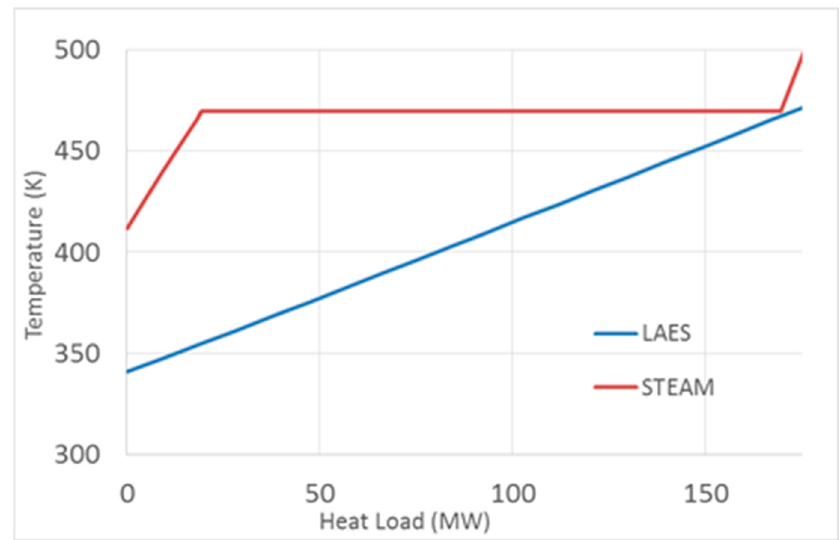
Figure 6. Temperature profile of heat exchanger 4.